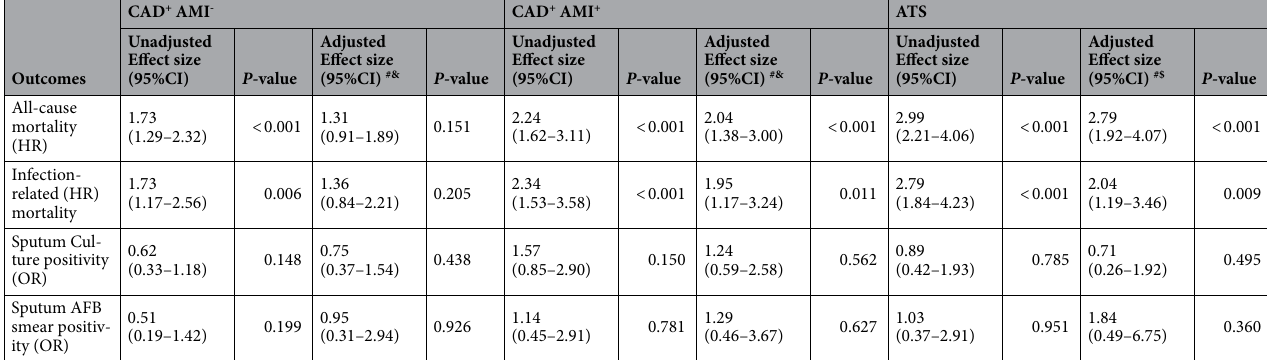
Table 2. Association of CAD with mortality and sputum microbiological status. AFB: Acid-fast bacilli; ATS: Atherothrombotic stroke, CAD + AMI + : Coronary artery disease with history of Acute myocardial infarction; CAD + AMI-: Coronary artery disease without history of Acute myocardial infarction, HR: Hazard ratio, OR: Odds ratio. # Adjusted for age, gender, body mass index (BMI), diabetes mellitus (DM), hypertension (HTN), cancer, chronic kidney disease (stage 3–5), asthma, chronic obstructive pulmonary disease (COPD), liver cirrhosis, transplant status, baseline sputum AFB status, cavitary disease at baseline, metformin use, statin use, and calcium channel blocker use. & Additionally adjusted for ATS. $ Additionally adjusted for CAD.